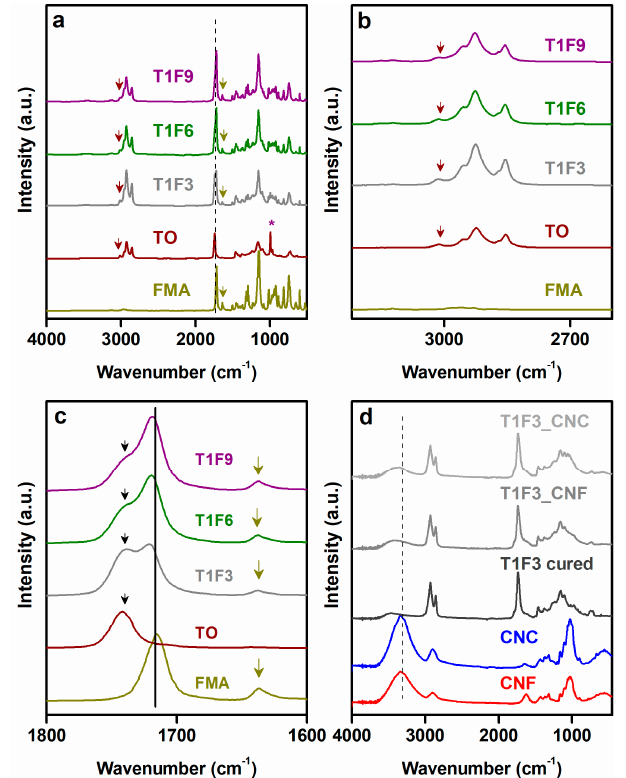
Figure 1. FTIR plots. ( a ) FMA, TO, and synthesized acrylated TO resins. Red and yellow arrows indicate the peaks at 3012 cm − 1 and 1636 cm − 1 , respectively, the red asterisk (*) indicates the peak at 996 cm − 1 , and the black dotted line indicates the peak at 1720 cm − 1 . ( b , c ) show the regions 2600–3250 cm − 1 and 1600–1800 cm − 1 , respectively (in Figure 1b, the peak at 3020 cm − 1 was highlighted with red arrow, and, in Figure 1c, the peaks at 1741 cm − 1 , 1720 cm − 1 , and 1635 cm − 1 are highlighted with black arrow, black solid line, and yellow arrow, respectively). ( d ) cellulose nanofiber (CNF), cellulose nanocrystal (CNC), cured T1F3 resin, T1F3_CNF, and T1F3_CNC biocomposites (black dotted lines indicate the –OH stretching at 3330 cm − 1 ). FTIR plots of cured T1F6, T1F9 resins and their composites are shown in Figure SI1.